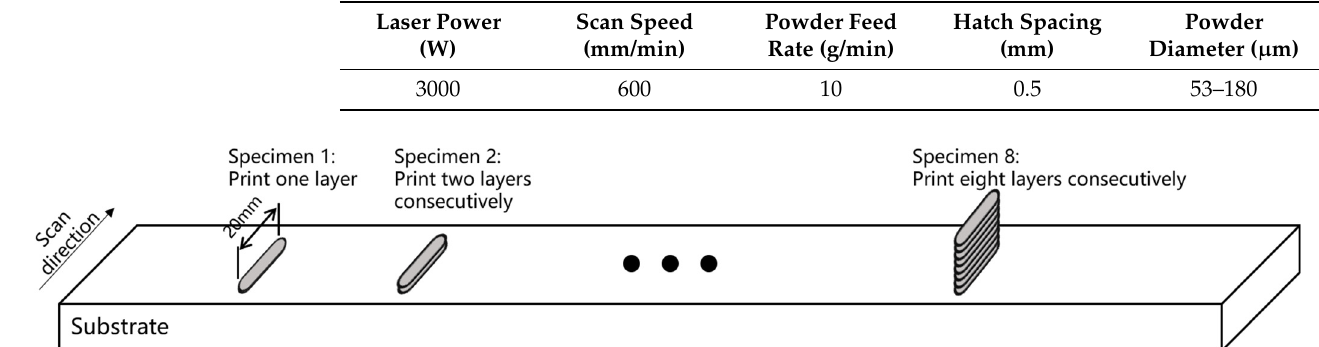
Figure 4. Schematic of the designed LMD experiment.